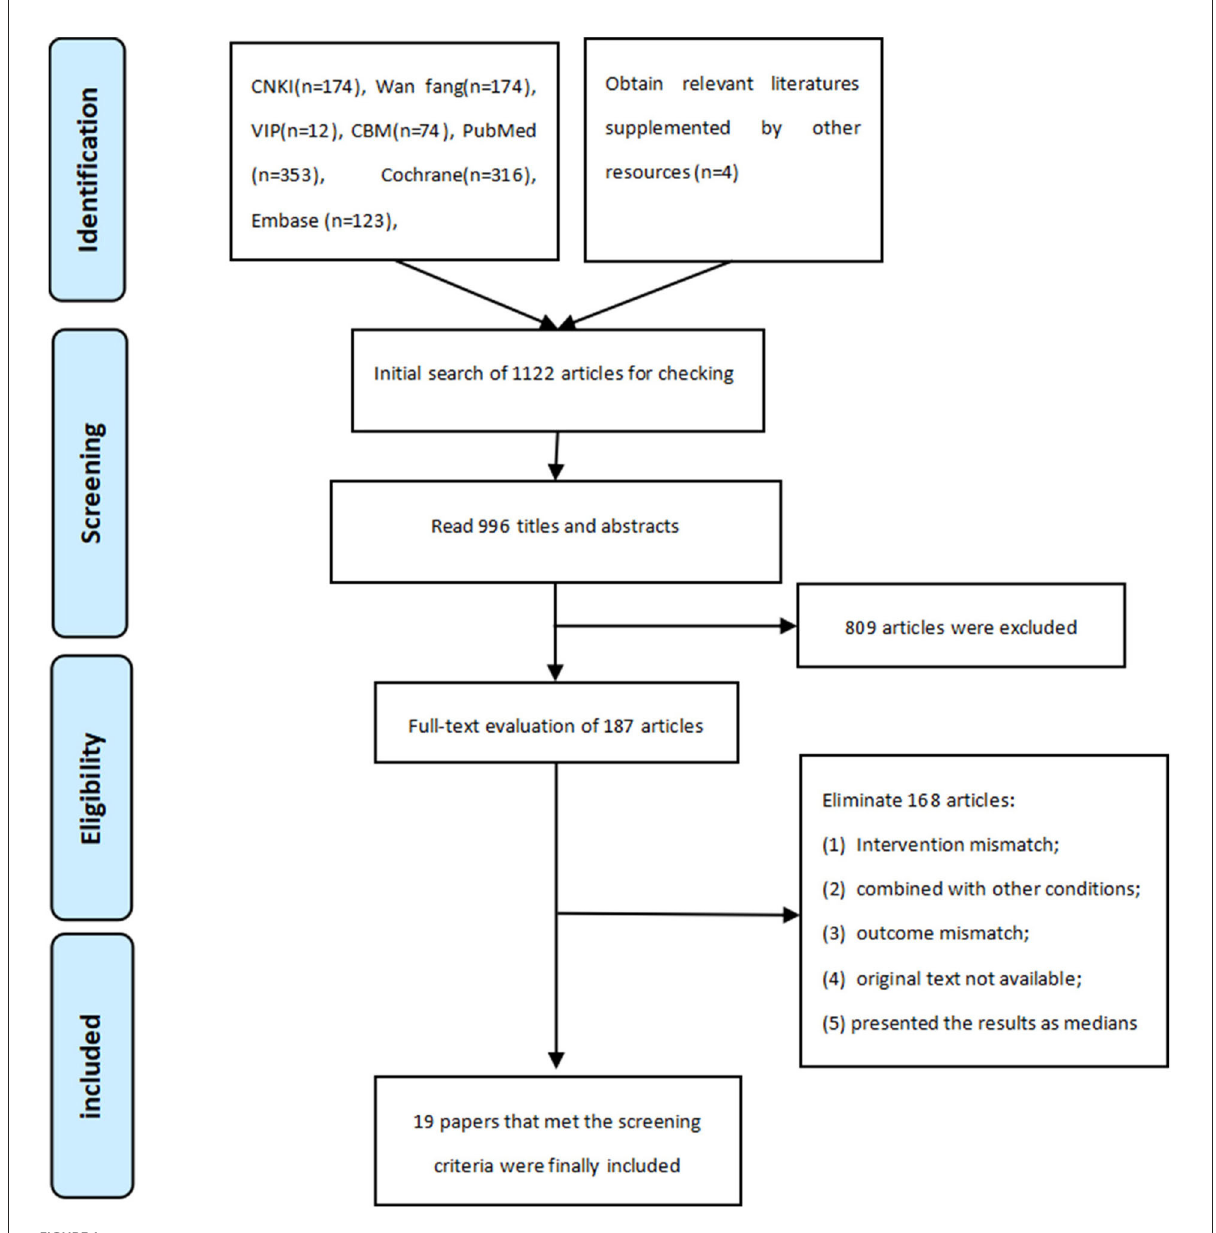
FIGURE1 Flow diagram of literature search and selection process.